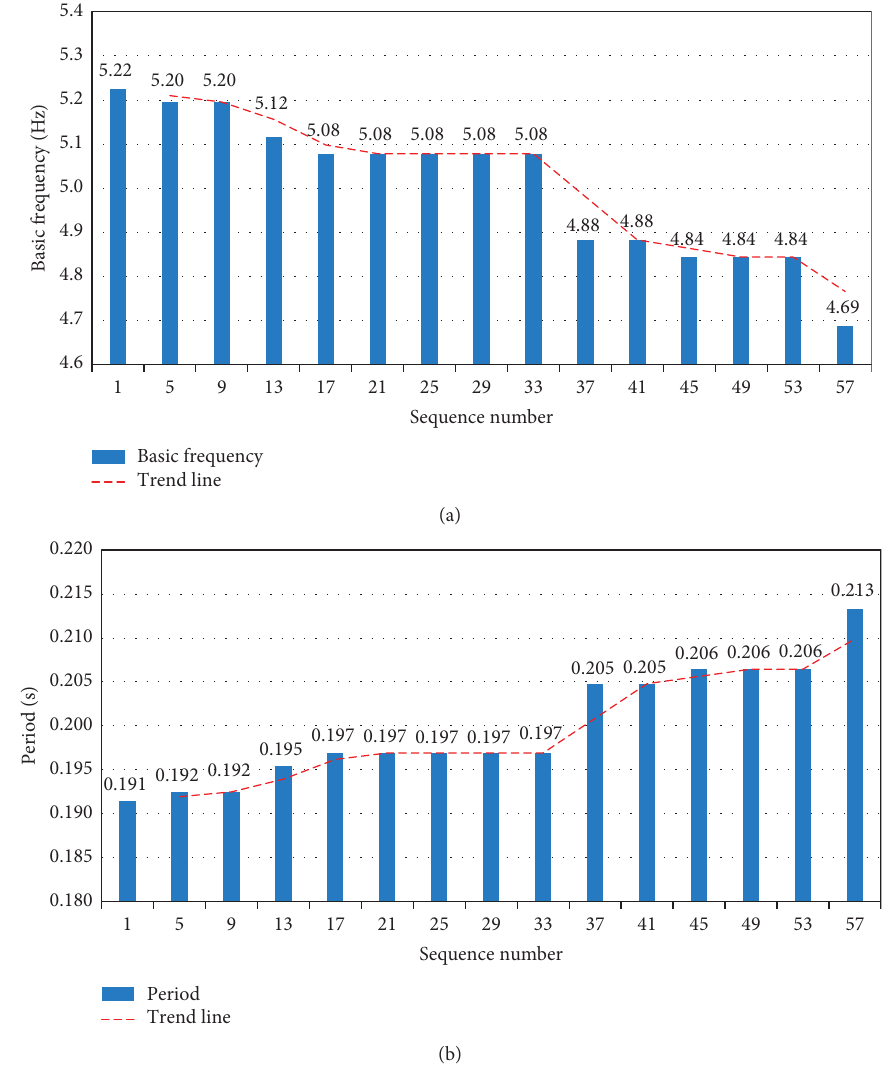
Figure 16: Evolution of basic frequency and period of the specimen. (a) Basic frequency. (b) Basic